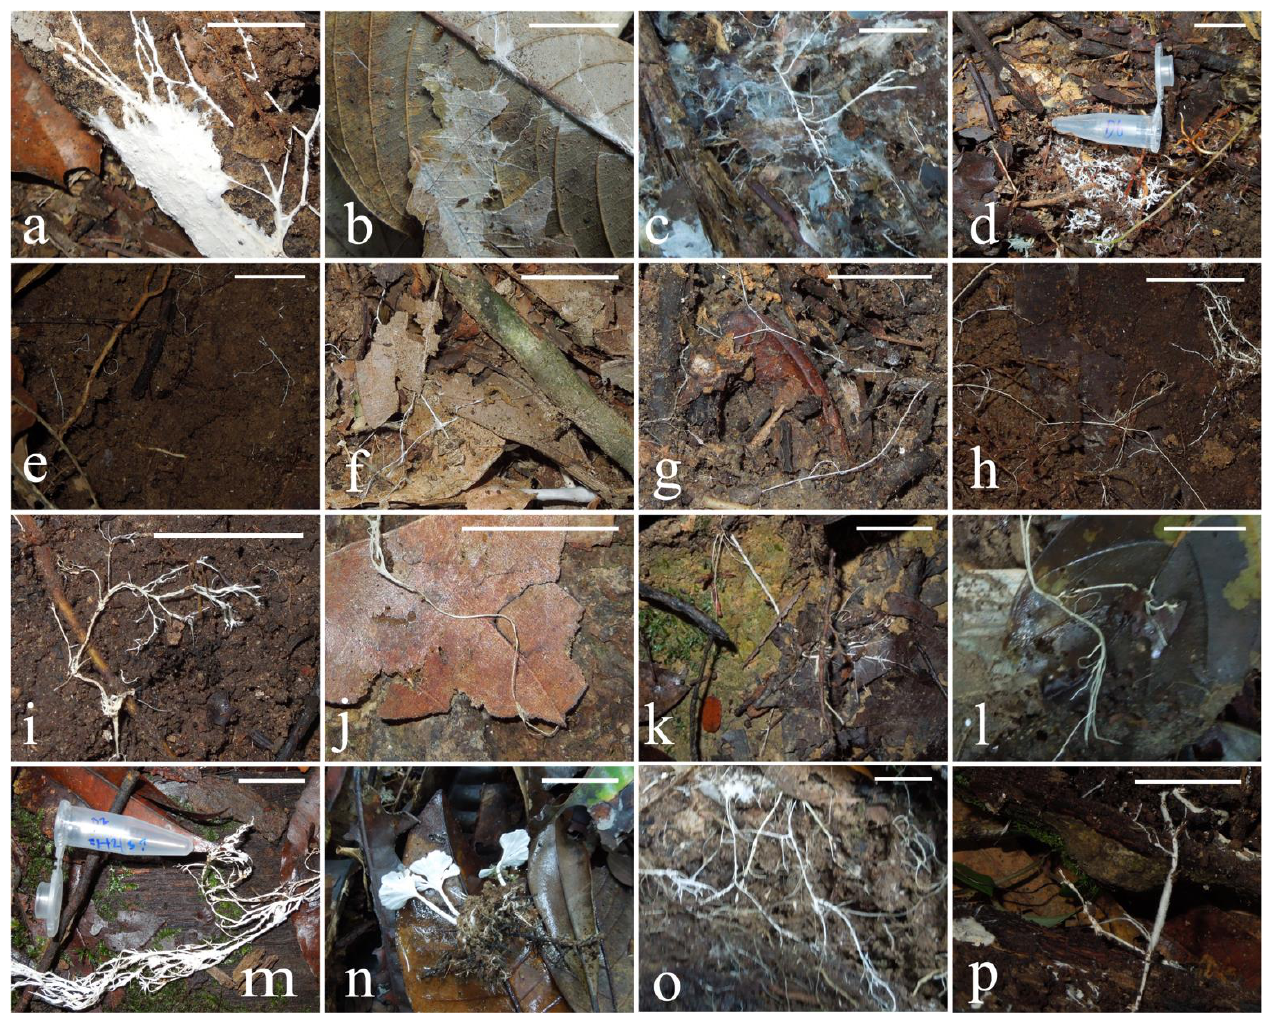
Figure 1. Photographs of fungi growing on leaf litter and small woody debris in situ prior to collection. Cords were loosely grouped according to thickness of cords. Scale bar is 2 cm. Sheet-forming: ( a ) BOR78, ( b ) BOR96, ( c ) BOR202, ( d ) BOR94. Thin cords: ( e ) BOR77, ( f ) BOR79, ( g ) BOR81, ( h ) BOR82. Thick cords: ( i ) BOR 83, ( j ) BOR86, ( k ) BOR88, ( l ) BOR99, ( m ) BOR91, ( n ) BOR110, ( o ) BOR201, ( p ) BOR80.